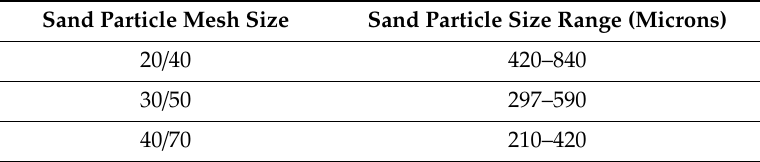
Table 1. Size ranges of the sand particles used in the